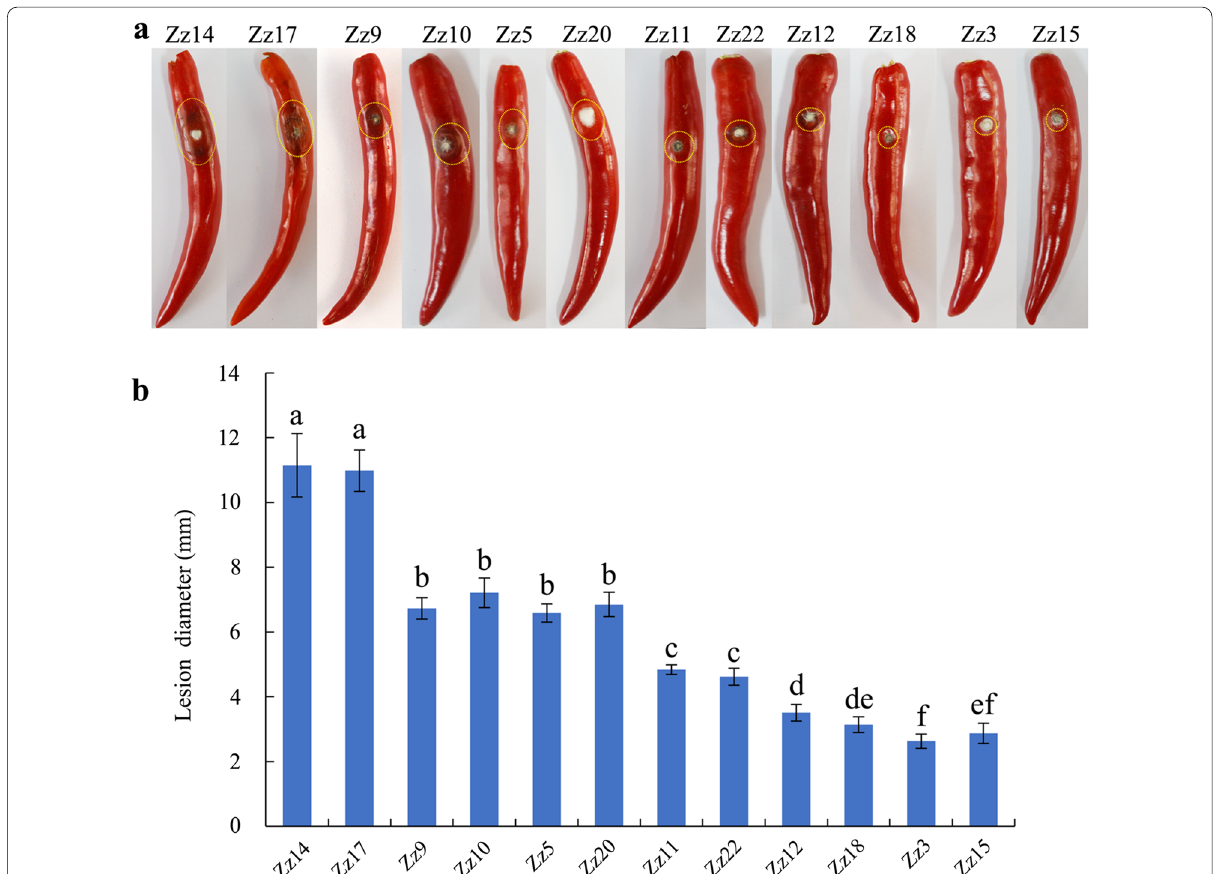
Fig. 4 Tebuconazole-resistant Colletotrichum siamense isolates are defective in virulence on chili fruits. a Fruit lesions caused by inoculation with tebuconazole-sensitive or tebuconazole-resistant isolates of C. siamense . Mycelial plugs (5 mm in diameter) from each isolate were used as the inocula, and disease symptom was examined after 7 days of inoculation at 25 °C. b Column diagram showing the lesion size in a . Lesion sizes were measured at 7 days post-inoculation. Error bars denote the standard deviations from three repeats. Different letters indicate significant differences according to the Fisher’s LSD test at P =